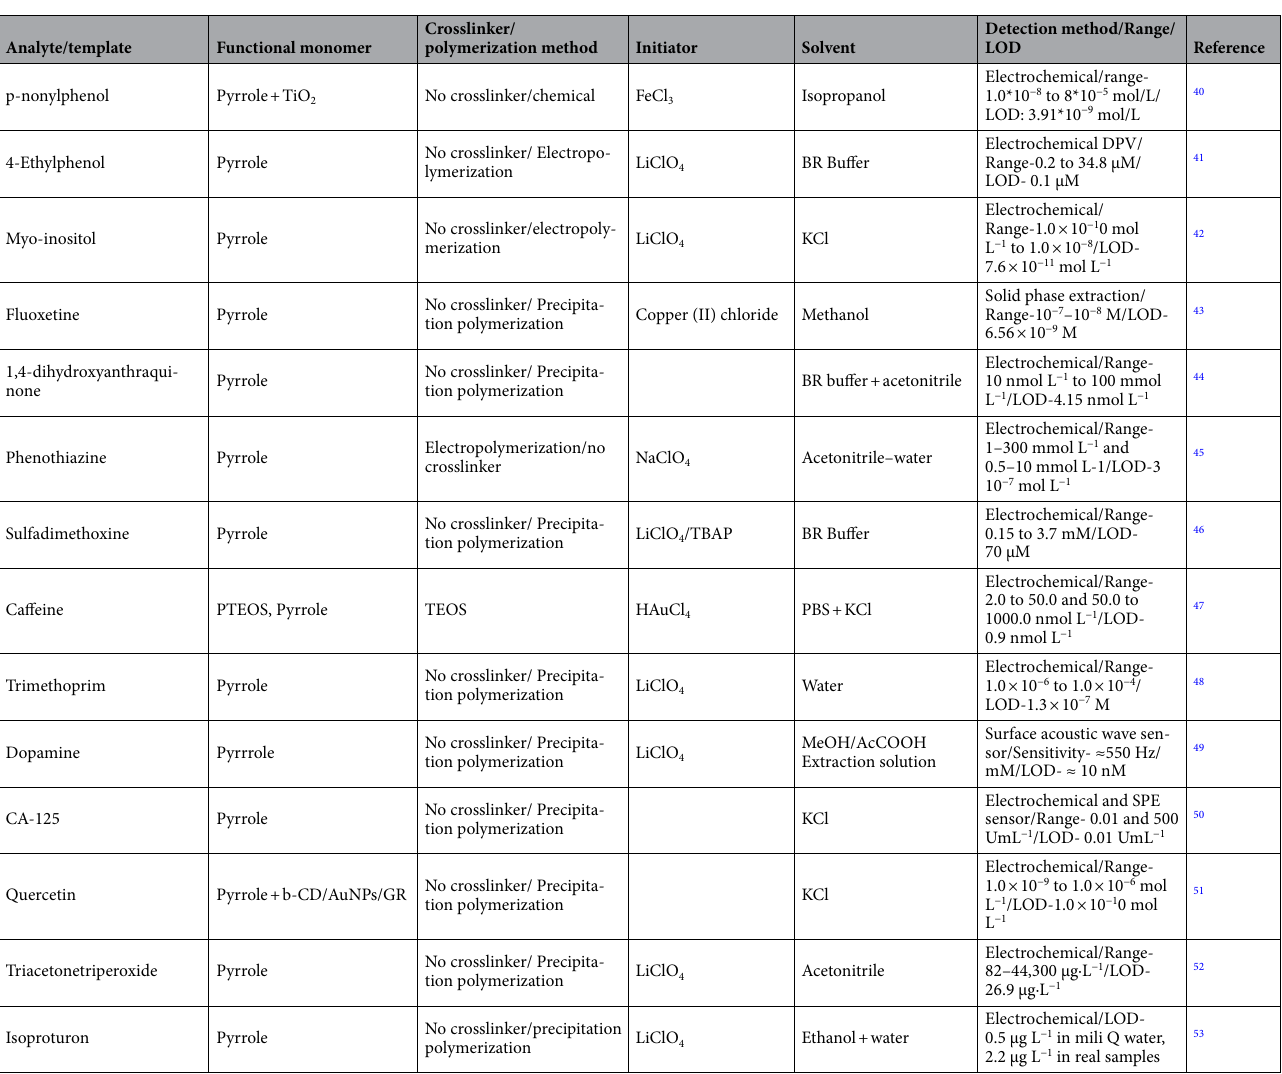
Table 2. Various pyrrole based MIP electrochemical sensors developed for different